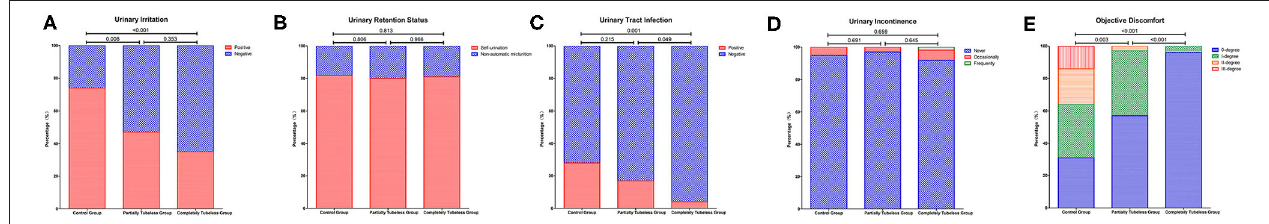
FIGURE 3 | Urinary system–related outcomes among the groups. (A) Incidence of urinary irritation; (B) Incidence of urinary retention; (C) Incidence of urinary tract infection; (D) Incidence of uroclepsia; (E) Objective discomfort of patients.